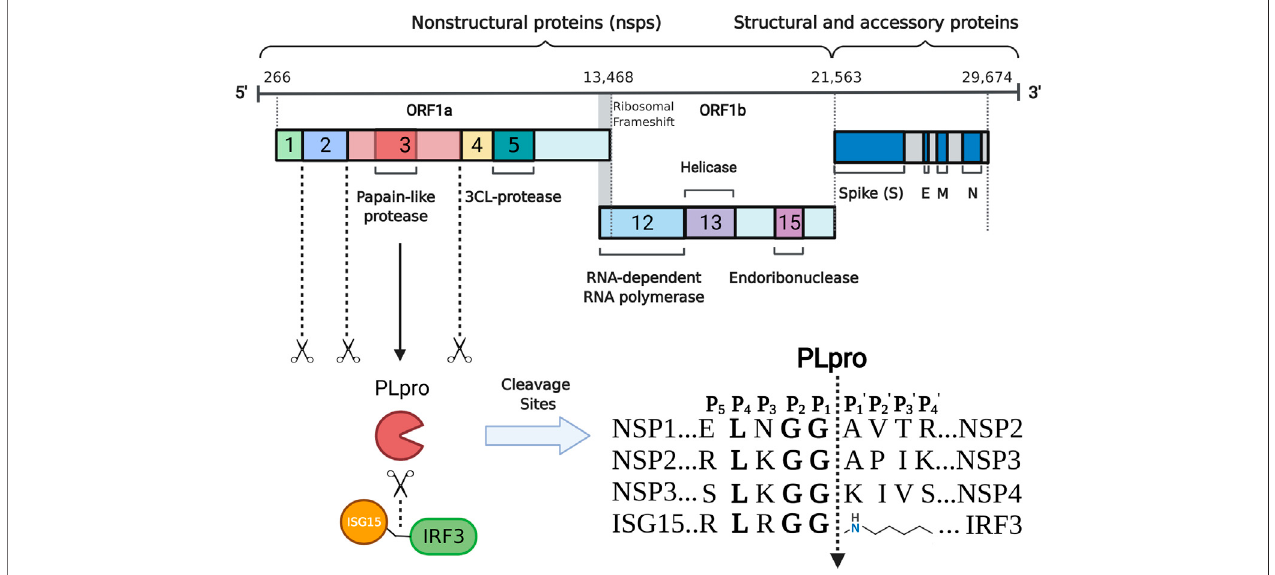
FIGURE 1 | Schematic representation of the production and function of SARS- CoV- 2 PLpro. The positive- strand RNA (numbers indicate nucleotide position) includingtheORF1a/b,structuralproteinsS(spike), E(envelope),M(membrane)andN(nucleocapsid) areshown.PLproisencoded bypart ofnsp3.Itisabletomature nsp1- 3 and preferentially cleave the ubiquitin- like protein ISG15 from IRF3 by recognizing speci fi c cleavage